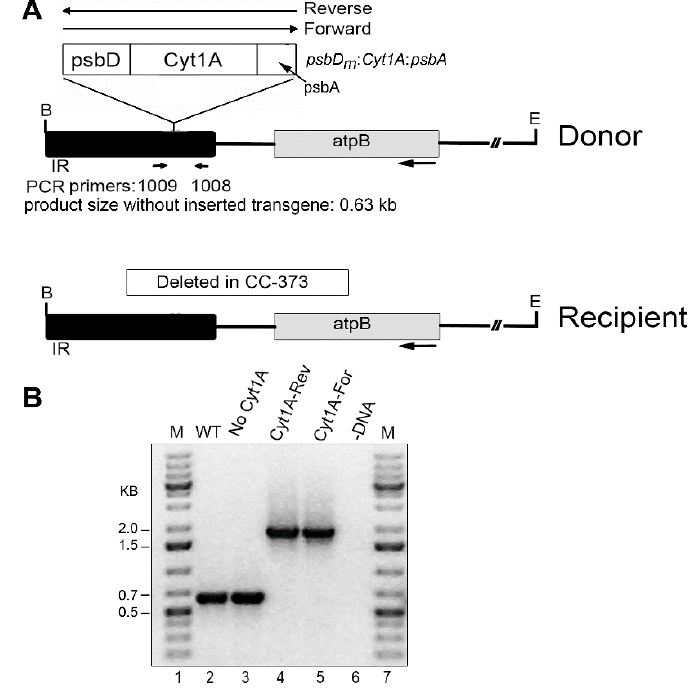
Figure 1. Introduced DNAs and analysis of homoplasmic cyt1Aa /CC-373 transformants by PCR. ( A ) Diagrams of the DNA constructs used for chloroplast transformation (Donor), and of the targeted region of the host, Chlamydomonas strain CC-373 (Recipient). In the Donor DNA, the psbD m :cyt1Aa:psbA gene was cloned into the IR region near atpB in both orientations, Reverse and Forward. The locations of the primers used for PCR (1009 and 1008) are indicated below the Donor DNA; these sites are created in Recipient DNA after repair of the deletion by homologous recombination with Donor DNA. B, E indicate restriction sites for Bam HI and Eco RI, respectively. The size of the PCR product if there is no transgene, 0.63 kb, is indicated; with the transgene, the expected product is ~1.8 kb (0.63 + 1.2). ( B ) PCR analysis of homoplasmic transformants. PCR was performed with total DNA from the indicated strains and primers 1009 and 1008. Lanes: M, DNA size markers; WT, CC-1690; No Cyt1A (CC-373 transformant that lost the psbD m :cyt1Aa:psbA gene by copy-correction with the other copy of the IR); Cyt1A-Rev (a transformant shot with Donor DNA that had psbD m :cyt1Aa:psbA in the Reverse orientation); Cyt1A-For (a transformant shot with Donor DNA that had psbD m :cyt1Aa:psbA